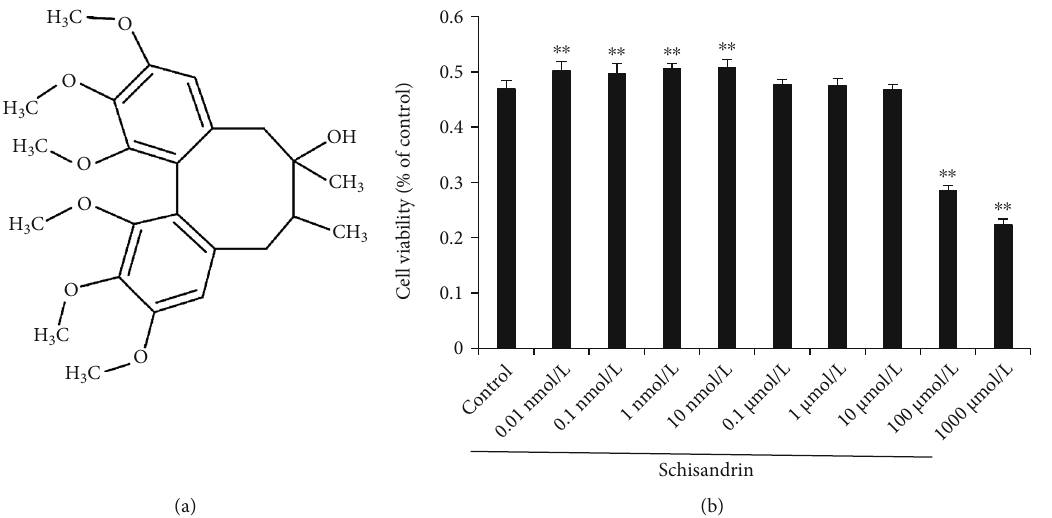
Figure 1: (a) Chemical structure of Schisandrin. (b) E ff ects of di ff erent concentrations of Schisandrin on cell viability. Cells were incubated with di ff erent concentrations of Schisandrin (0.01, 0.1, 1, and 10nmol/L or 0.1, 1, 10, and 100,1000 μ mol/L) for 48h. Cell viability was evaluated using the MTT assay. ∗∗ p < 0 : 01 , compared with the control group.